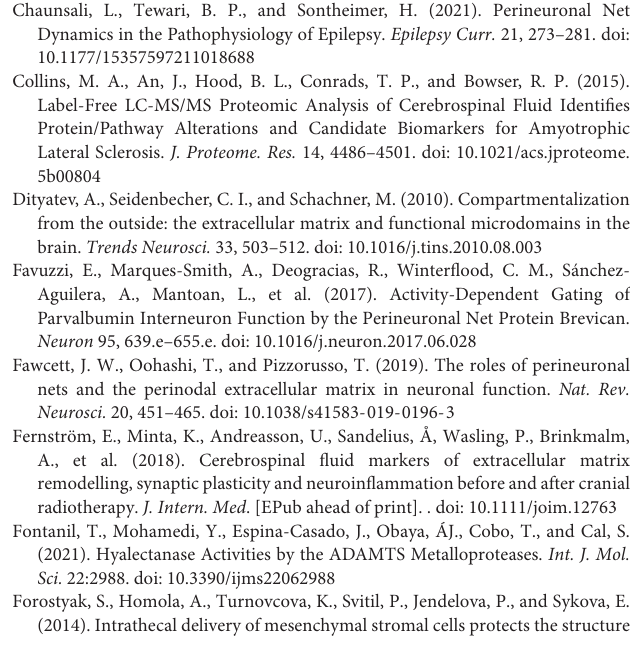
Supplementary Figure 1 | The neo antibody recognizes the human brevican fragment in the CSF. Western blot showing the result of the antigen competition experiment to prove specificity of the antibody directed against the C-terminal neoepitope of the N-terminal brevican fragment. In human CSF the antibody shows reactivity with a 60kDa protein band (lane A, arrow) which is clearly reduced after preincubating the antibody with a 100fold molar excess of the rat brevican peptide used for immunization (lane D). The band at 70kDa results from cross-reactivity with albumin (asterisk), which is not affected by the competition experiment. In soluble fractions of human temporal (tCtx; B) and frontal (fCtx; C) cortex the antibody does not show any blockable specificity in the 60kDa range (lanes E, F). Protein marker (M) sizes are indicated (in kDa). Supplementary Figure 2 | Example immunoblots of cleaved brevican (A) and neurocan (B) immunoreactivity in individual CSF samples and a reference sample loaded on all gels for calibration. Protein marker (M) sizes are indicated (in kDa). Ctrl – control; HA – hypertensive arteriopathy; CAA – cerebral amyloid angiopathy; ALS – amyotrophic lateral sclerosis; Ref – reference sample. Quantified bands are indicated with arrows. Asterisk marks the nonspecifically labelled albumin band. Supplementary Figure 3 | Neurocan levels in the CSF of epilepsy patients with or without subacute encephalitis. Group-wise comparison of z-scores from age- and sex-corrected total concentrations of neurocan as measured via ELISA (A) , and of the cleaved neurocan-C fragment as measured via immunoblot (B) . Statistical significance is